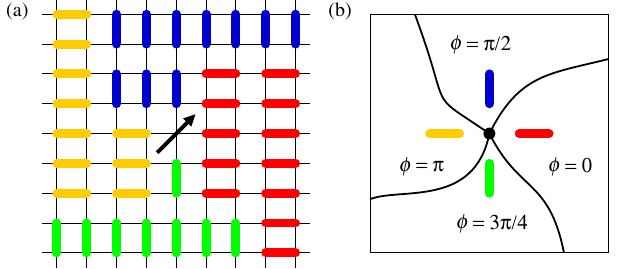
FIG. 3. (a) Illustration of a spinon forming at an unpaired spin at the nexus of domain walls separating the four different columnar VBS patterns on the square lattice. (b) The four VBS patterns associated with angles ϕ in a simplified view of the VBS vortex, with only the bonds closest to the core shown in the same color coding as in (a). A similar vortex can also be constructed starting from core bonds rotated by 90° relative to those shown